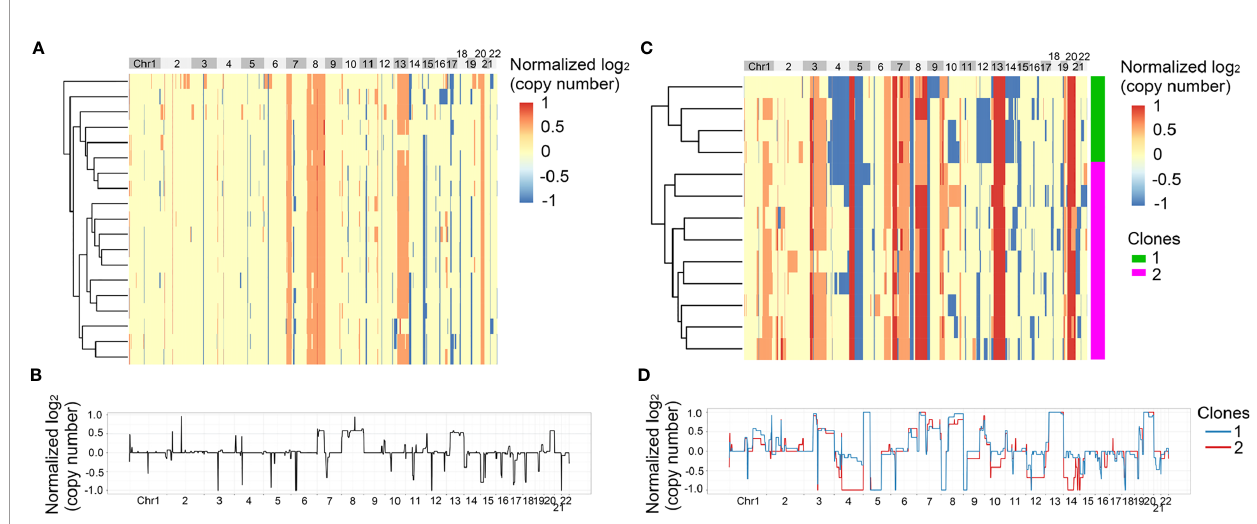
FIGURE 3 | CNV heterogeneity of primary tumor in Pt.1 and Pt.2. (A) A heatmap of single cell copy number pro fi les in Pt.1 with the clustering analysis based on CNVs on the left. (B) A plot showed the normalized average copy numbers of all the single cells from primary tumor in Pt.1. (C) A heatmap of single cell copy number pro fi les in Pt.2 with the clustering analysis based on CNVs on the left. All the cells were divided into two subclones. (D) A plot showed the normalized average copy numbers of the two subclones from primary tumor in